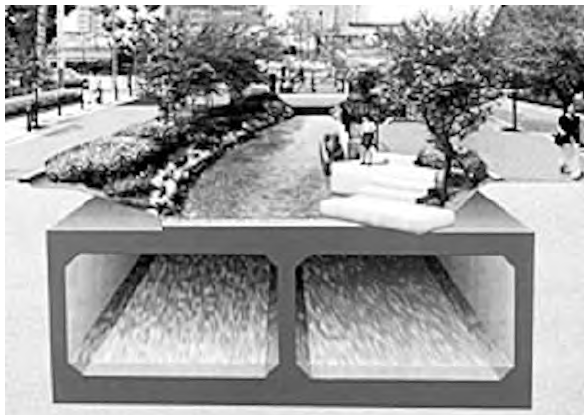
Figure 10. Nanase River, Layered plan Source: Kyoto City Official